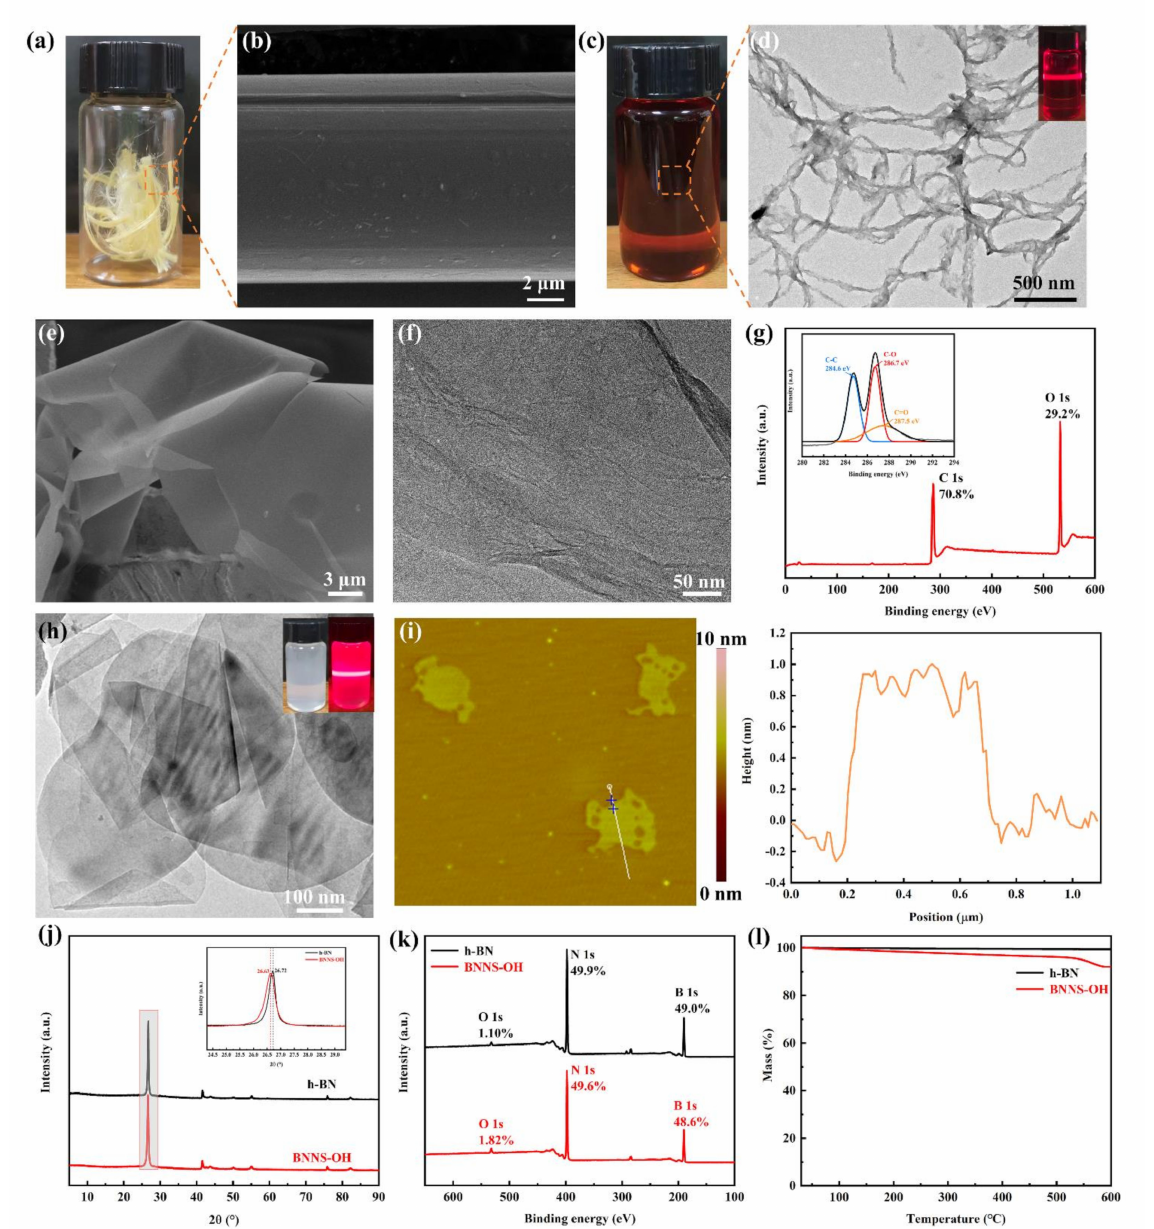
Figure 2. ( a ) Optical photograph of the macroscopic Kevlar fibers. ( b ) SEM image of Kevlar fibers. ( c ) Optical photograph of the ANFs dispersion. ( d ) TEM image of ANFs (inset: digital image of ANFs/DMSO solution with Tyndall effects). SEM ( e ) and TEM ( f ) images of GO. ( g ) XPS spectra of GO sheets (inset: XPS C1s spectra of GO). TEM ( h ) and AFM ( i ) images of BNNS-OH. Comparative ( j ) XRD patterns, ( k ) XPS profiles, and ( l ) TGA analysis between h-BN and